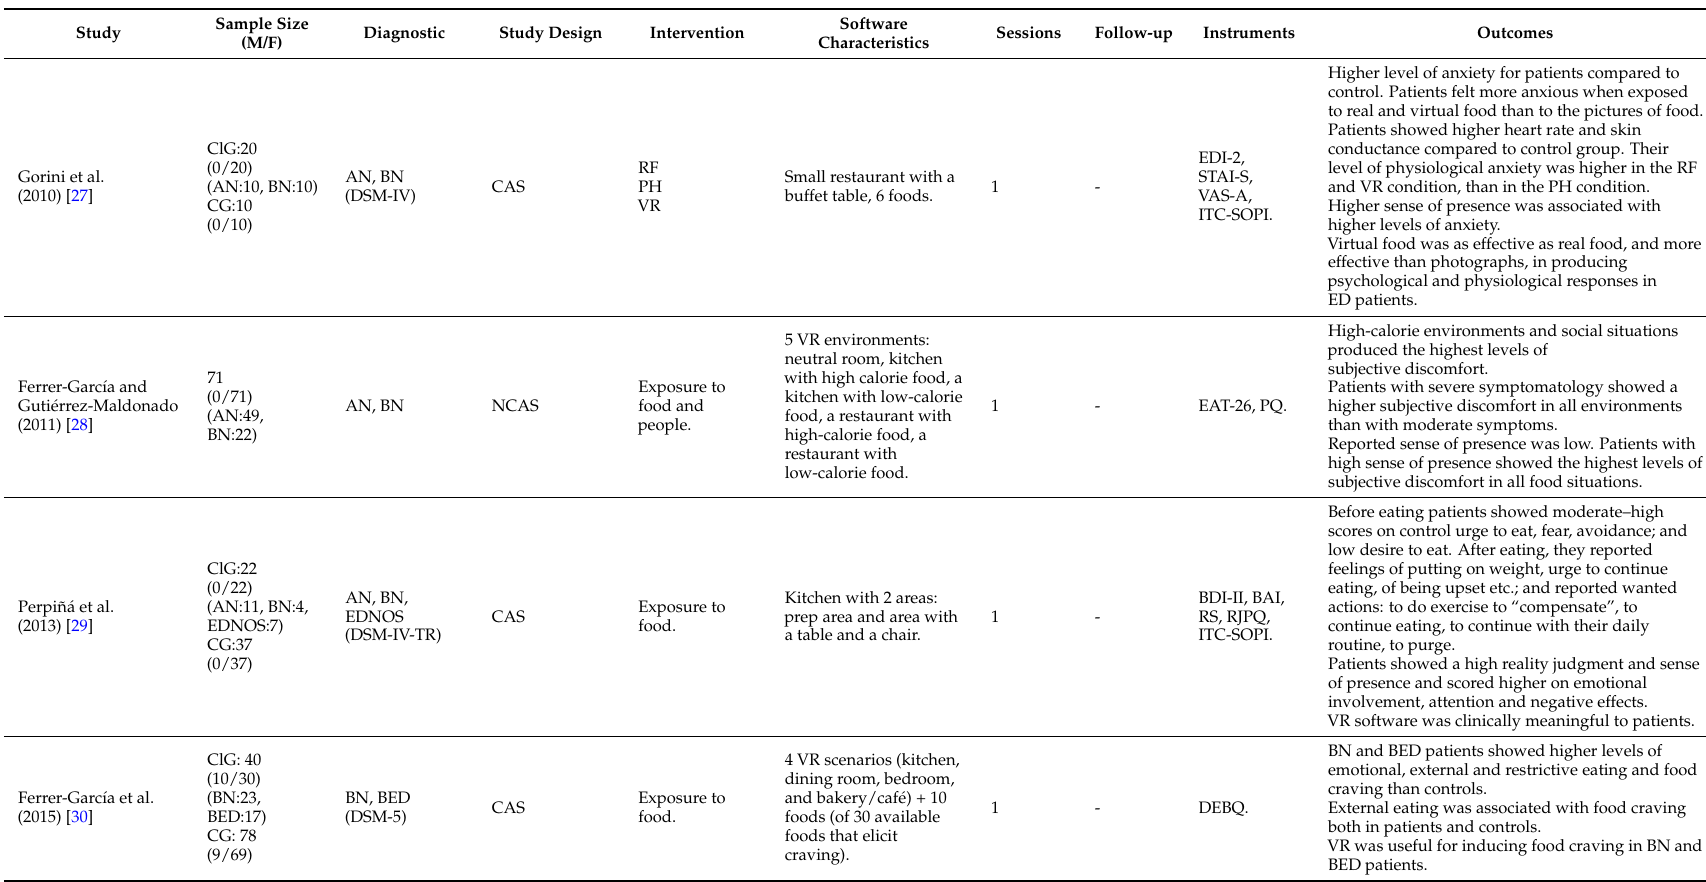
Follow-up Instruments